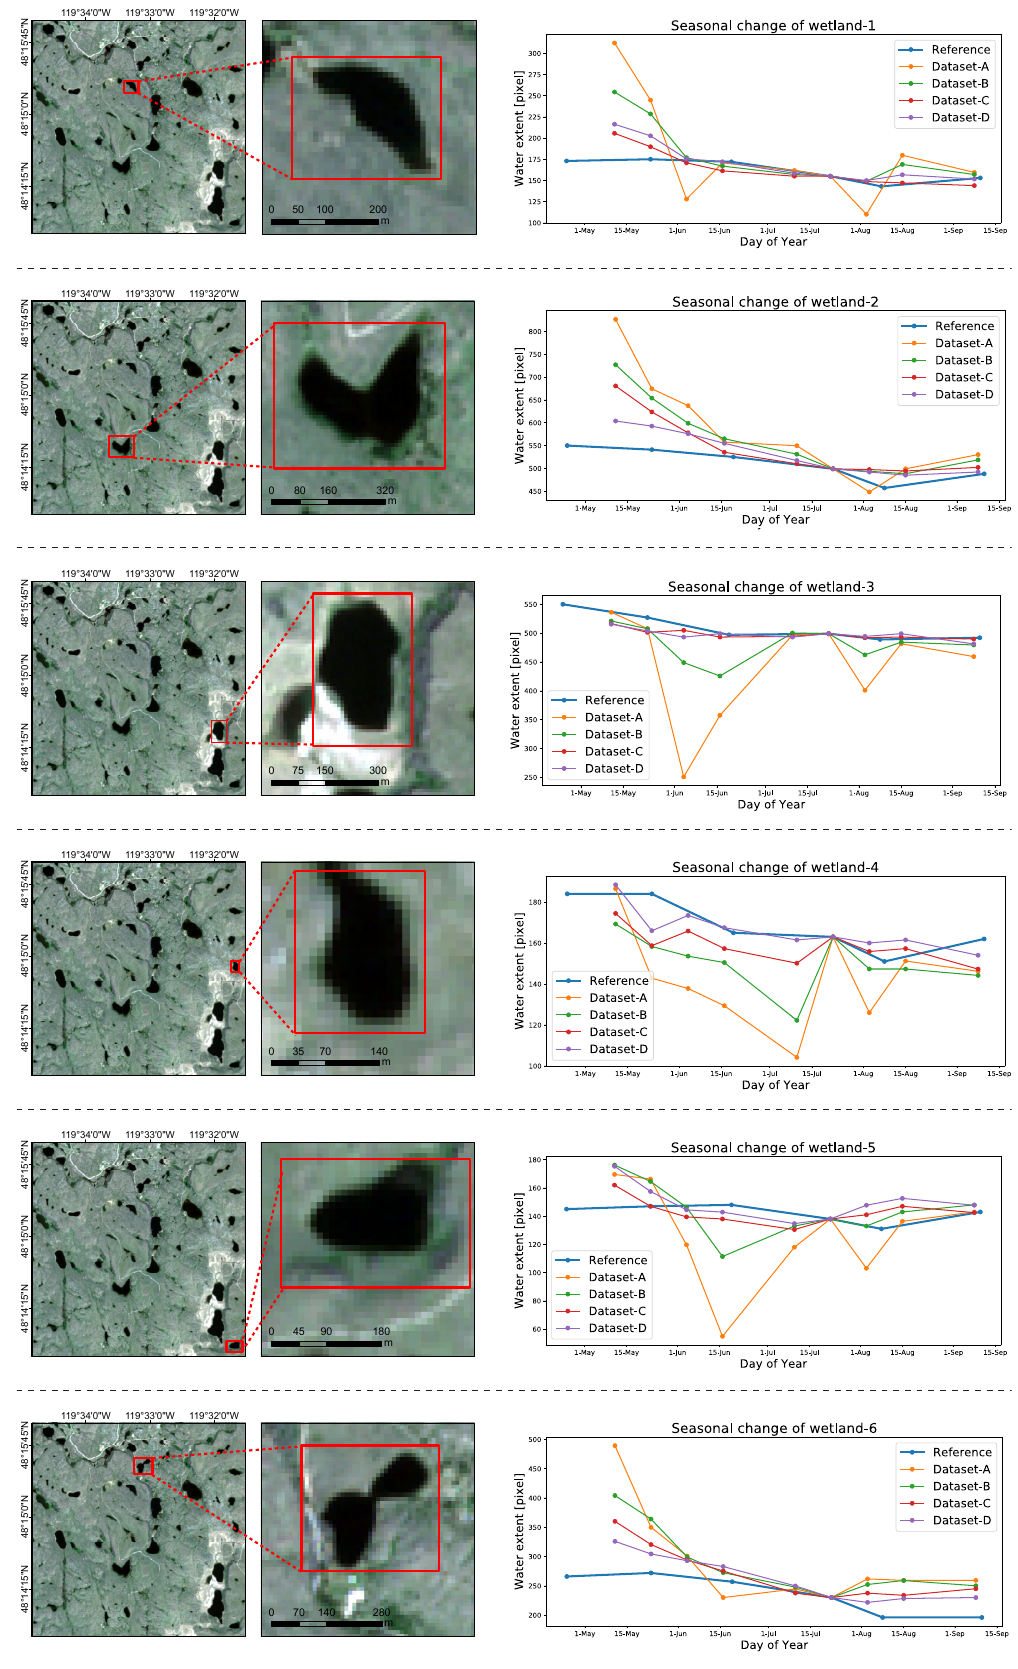
Figure 17. Extracted water extent change in the selected